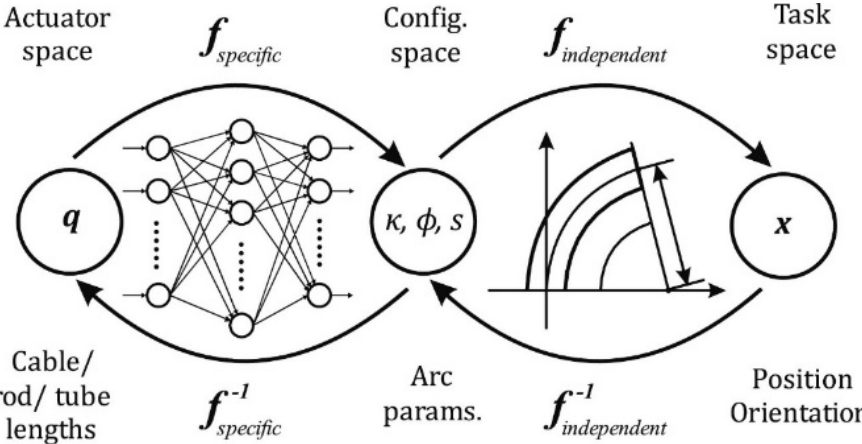
Figure 1. Mapping between spaces to define the kinematics of a constant curvature robot. Adapted from [4].